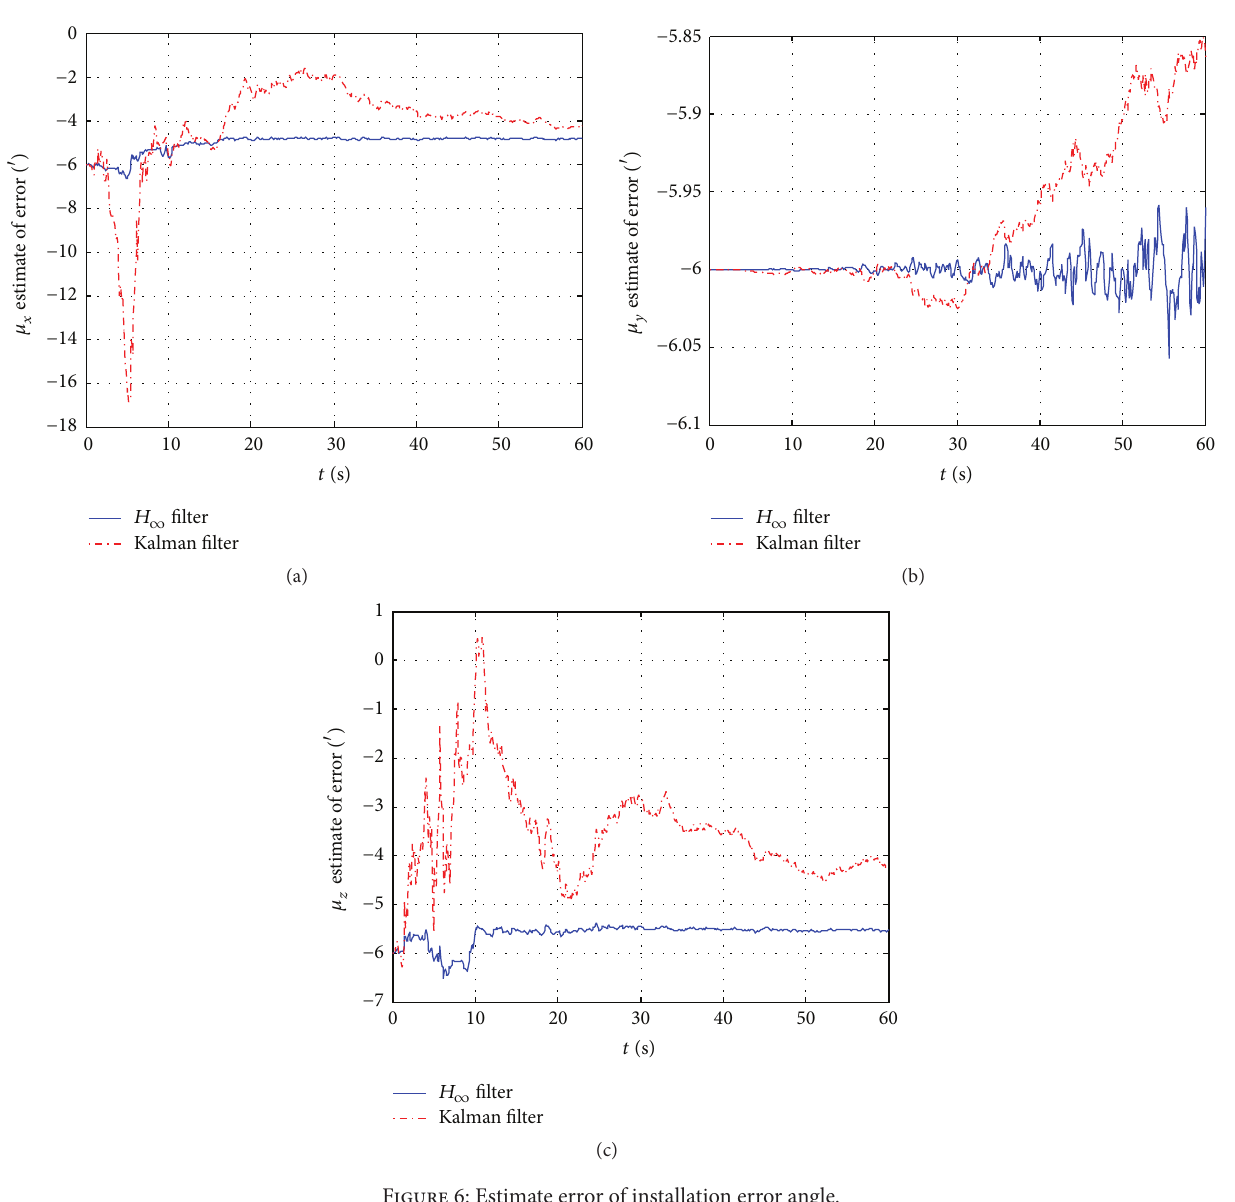
Figure 6: Estimate error of installation error